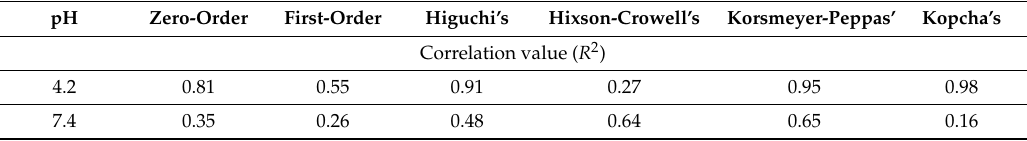
Table 4. Correlation co-e ffi cient ( R 2 ) obtained from modelling 5-FU-loaded 2% PEG-CHIT-MSNs through release kinetic models at pH 7.4 and